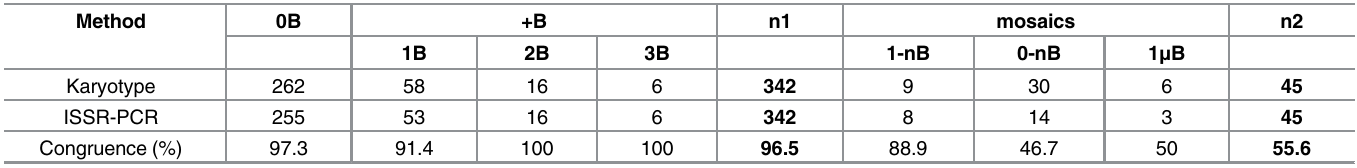
Table 1. Comparison between results of karyotyping and ISSR-PCR profiling with primer (CAG) 4 AC on a total sample of 387 individuals of A . flavicollis .